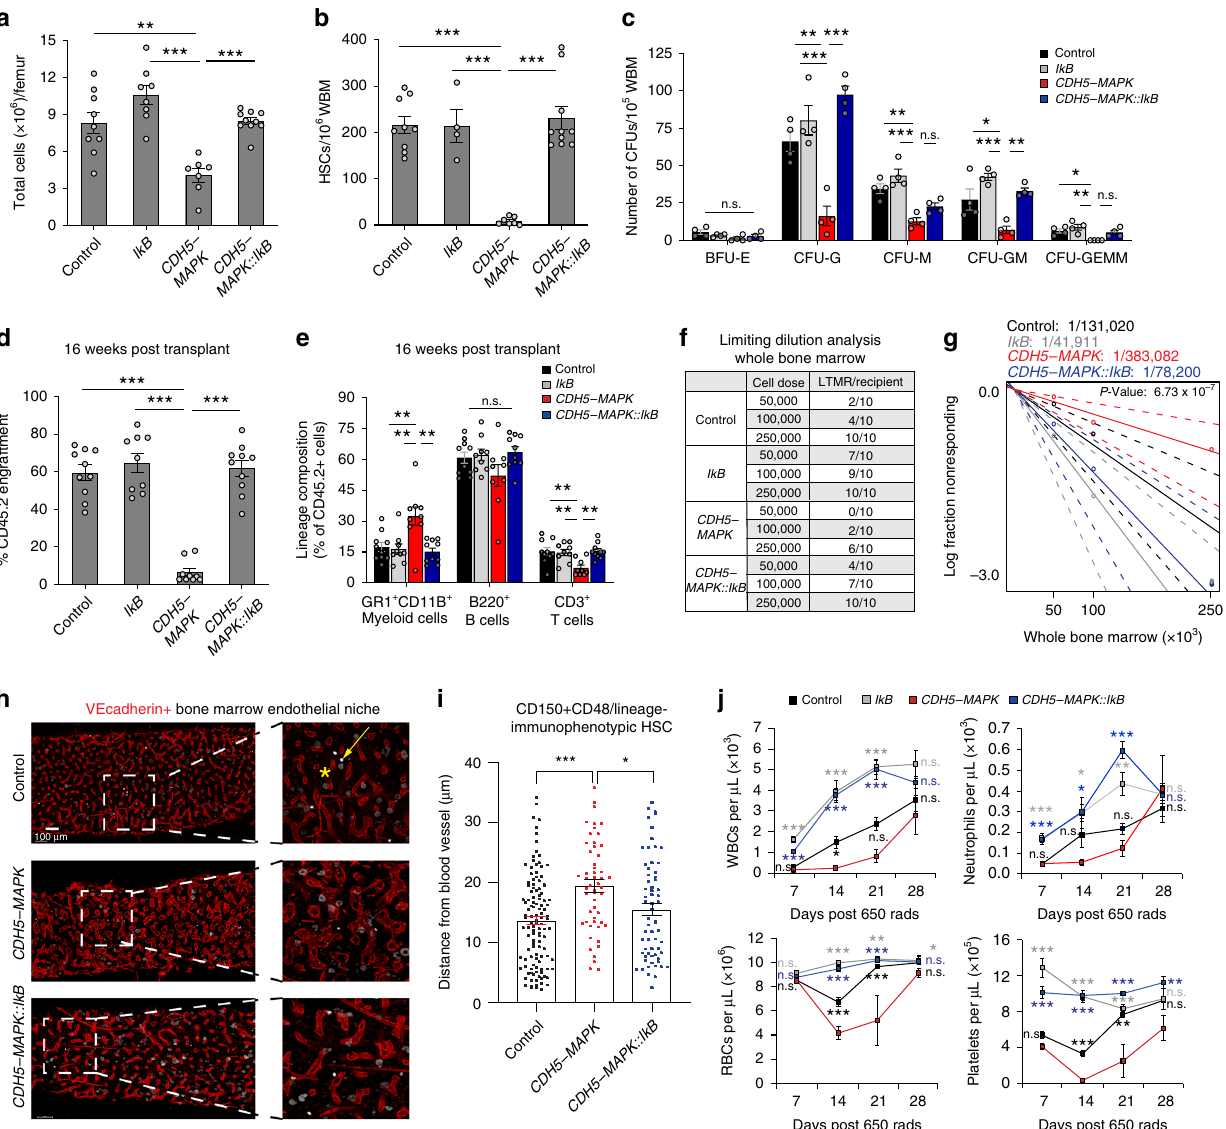
Fig. 4 Endothelial NF- κ B inhibition restores HSC activity in CDH5-MAPK mice. a Total cells per femur ( n = 7 – 10 mice/cohort). b Frequency